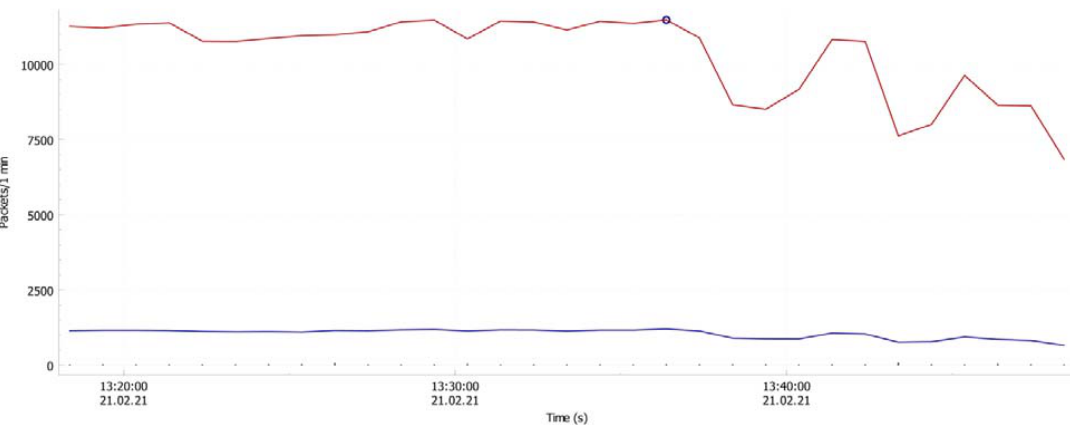
Figure 10. Traffic load in packets per minute in communication between the server and ten sensor nodes. Table 1 shows the average and maximal number of MQTT packets for all nodes (total MQTT) and for each node separately per second. The 10 sensor nodes are displayed in the table with the last octet of IP address (192.168.0.14, 192.168.0.15, 192.168.0.17, 192.168.0.18, Table 1. Server message queuing telemetry transport (MQTT) packet load per second in the 10 nodes scenario. TCP Errors